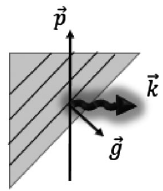
FIG. 7. Optimized crystal shape for a PXR